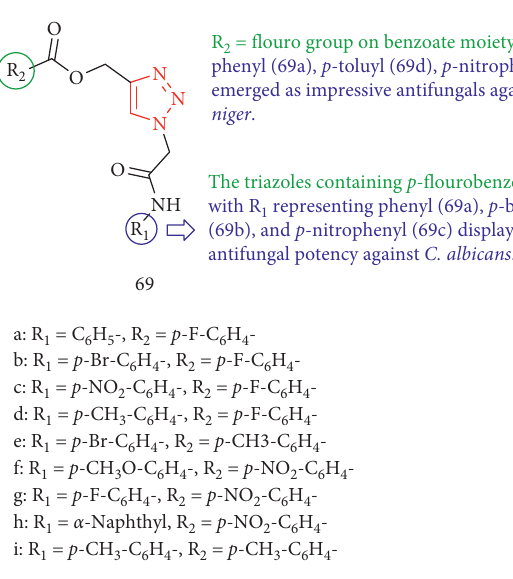
Figure 24: Chemical structure of amide-ester-linked 1,4-disubstituted